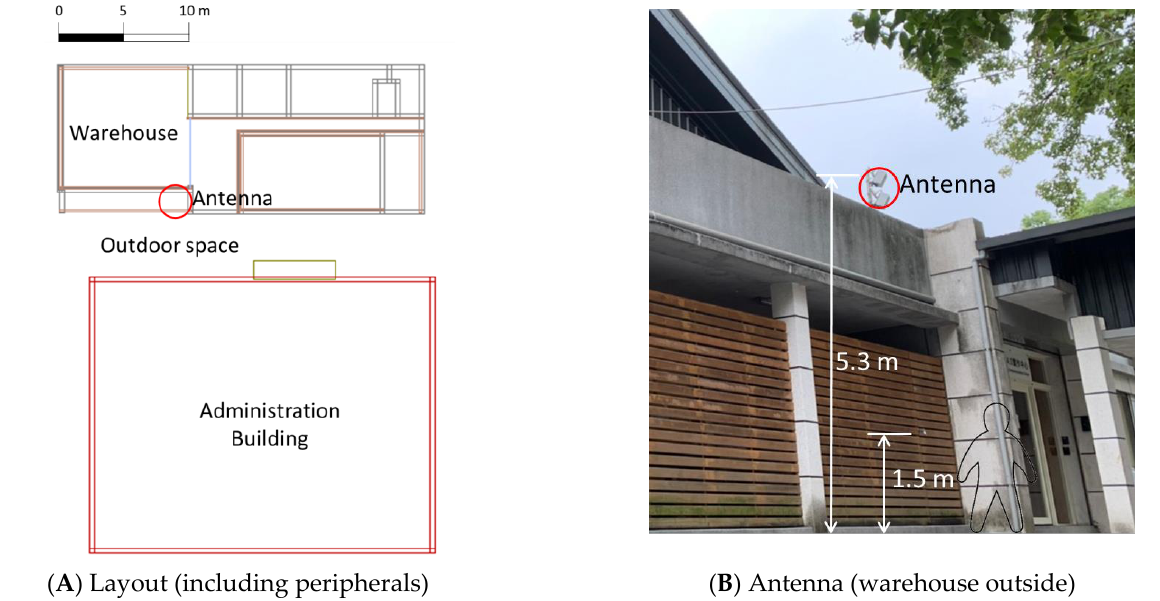
Figure 1. Testing environment. ( A ) Layout (CAD file). ( B ) Antenna at the testing site.